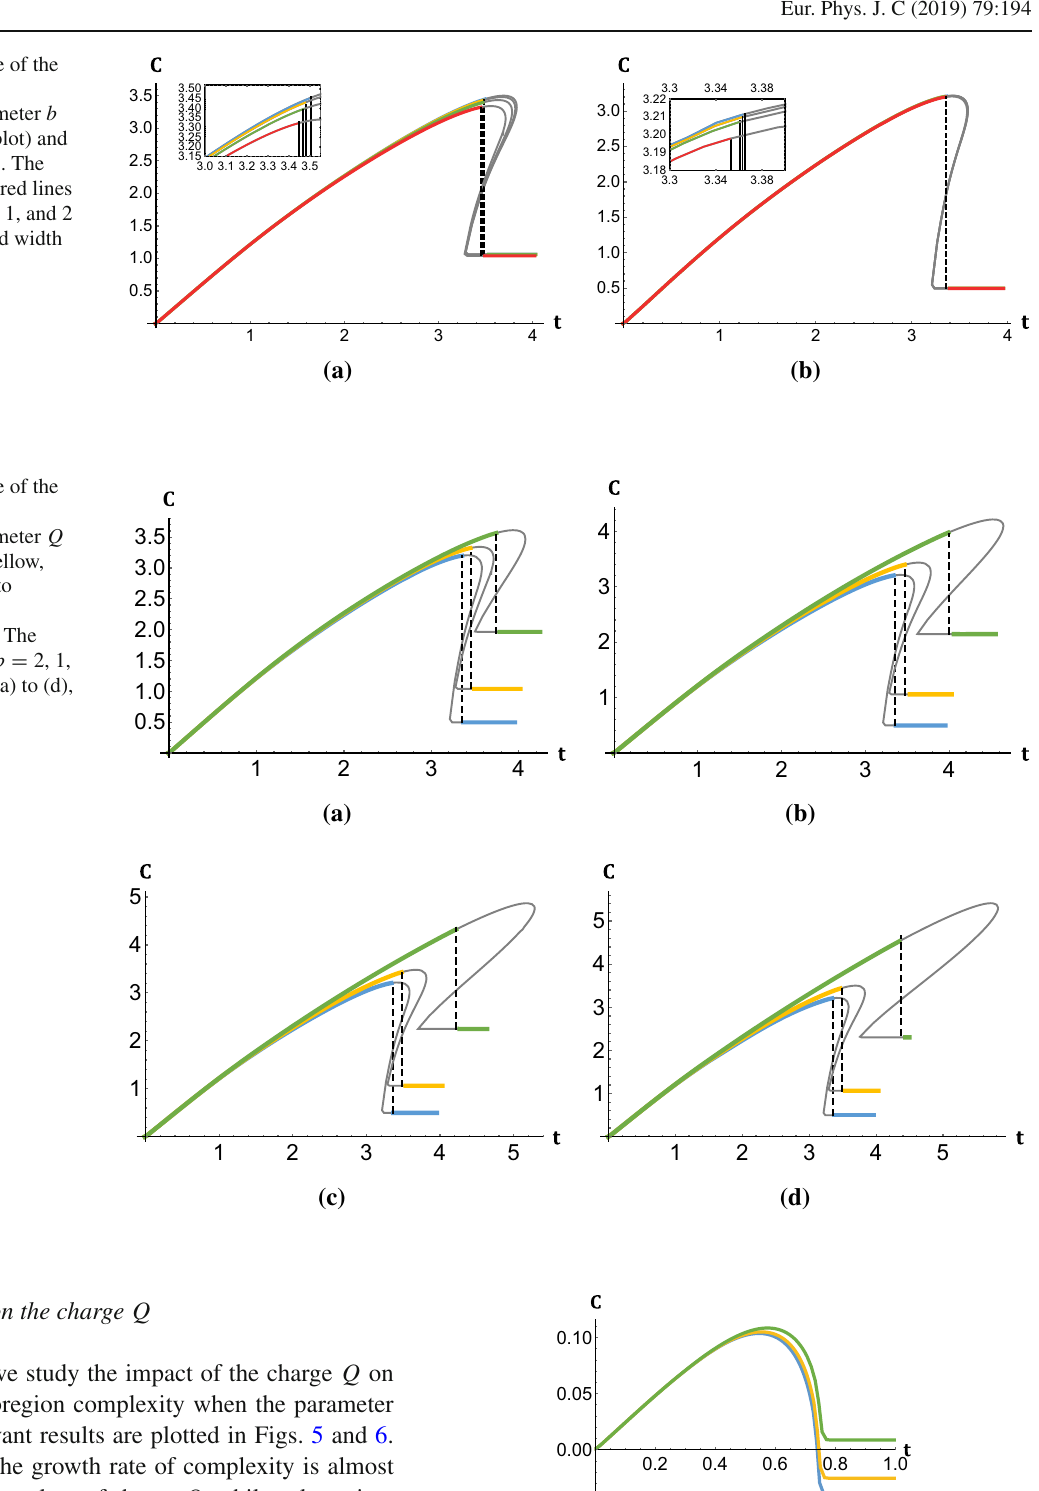
Fig. 6 The dependence of the holographic subregion complexity on the parameter Q with l = 1. The blue, yellow, green lines correspond to Q = 0 . 2, Q = 0 . 4 and Q = 0 . 65, respectively. The parameter b is fixed as b =